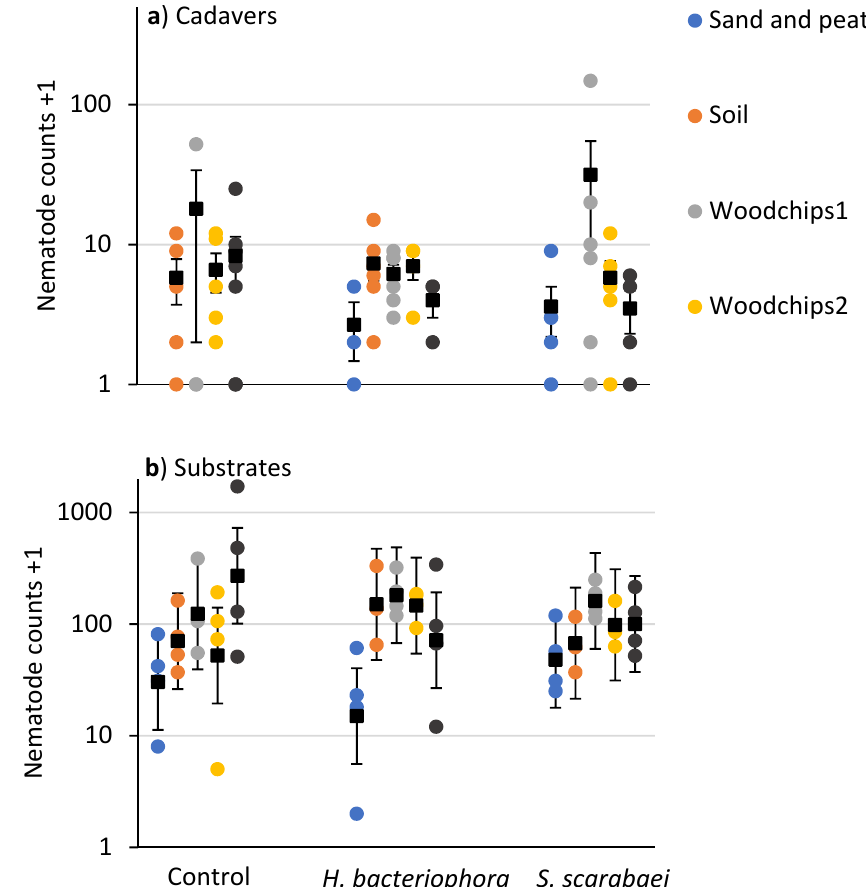
Figure 4. Counts (colored circles) and means (±SEM in ( a ) and ± 95% CI in ( b )) (black squares) of nematodes recovered in white traps from ( a ) Popillia japonica cadavers and ( b ) mulch samples taken 20 days after inoculation of outdoor microplots (30 × 30 × 30 cm) partially filled with sand and peat,